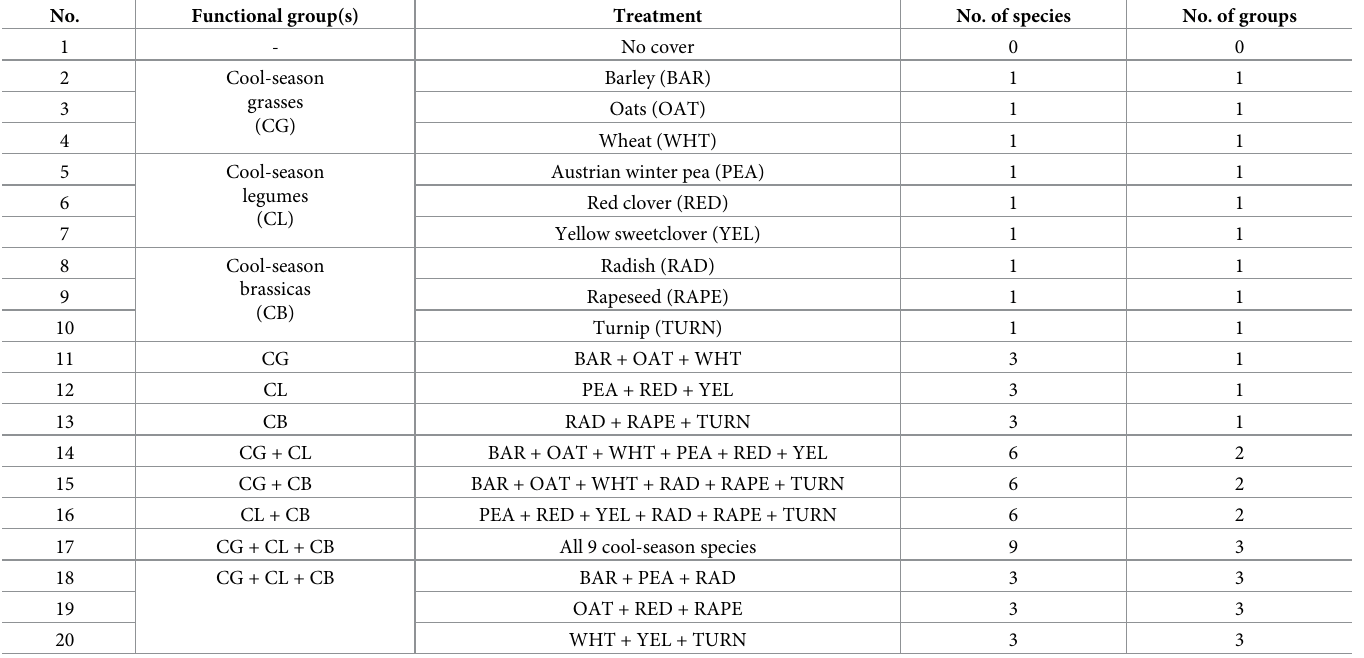
Table 2. Summary of cover crop treatments for